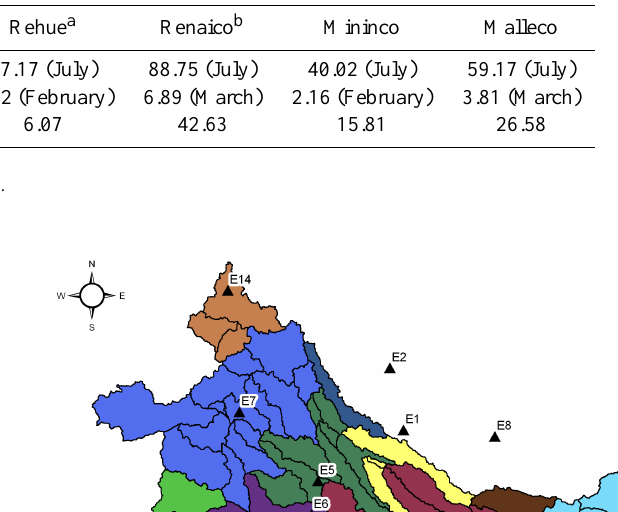
Table 4. Mean monthly discharges [m 3 s − 1 ] at the different control points in the Vergara basin (1977–2002).